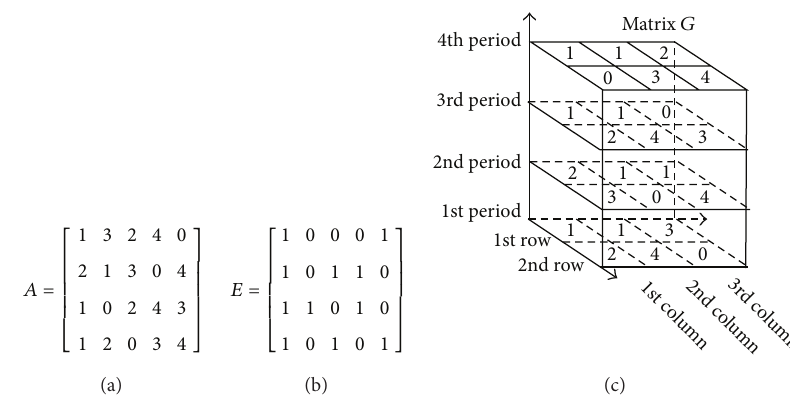
Figure 3: (a) Sample matrix 𝐴 ; (b) sample matrix 𝐸 ; (c) sample matrix 𝐺 derived from 𝐴 and 𝐸